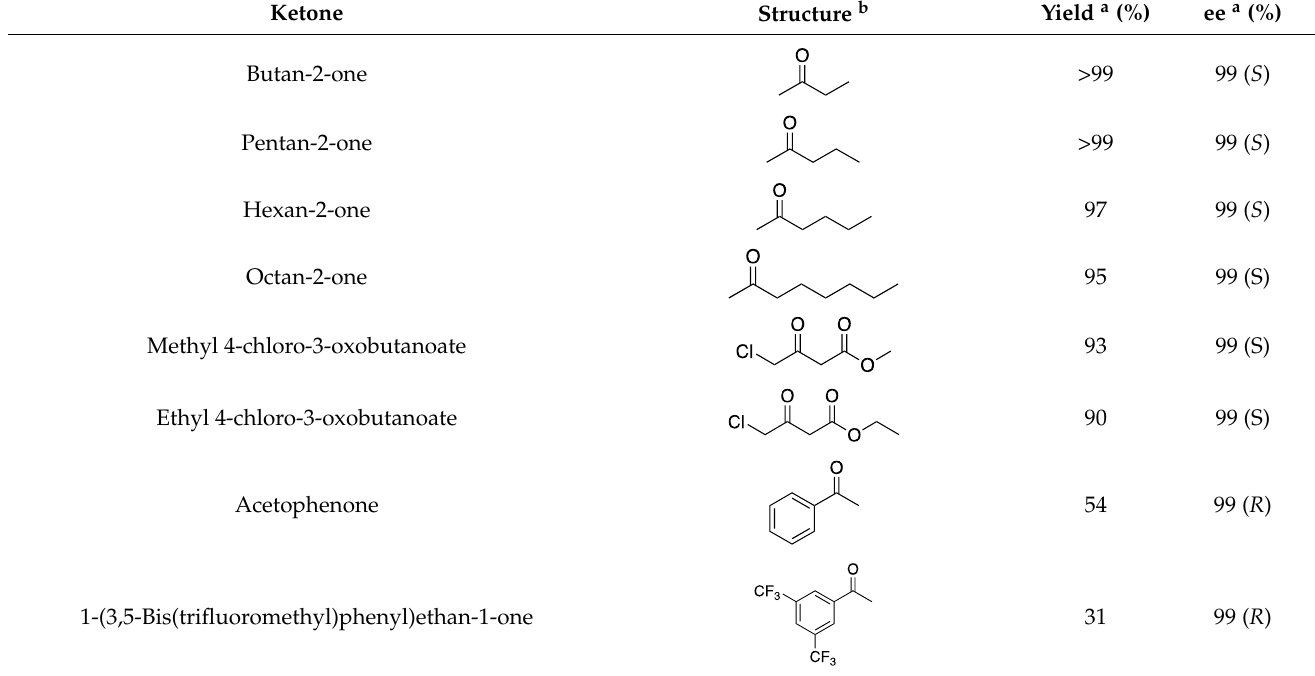
Table 2. Asymmetric reduction of different ketones by Curvularia hominis B-36. Ketone